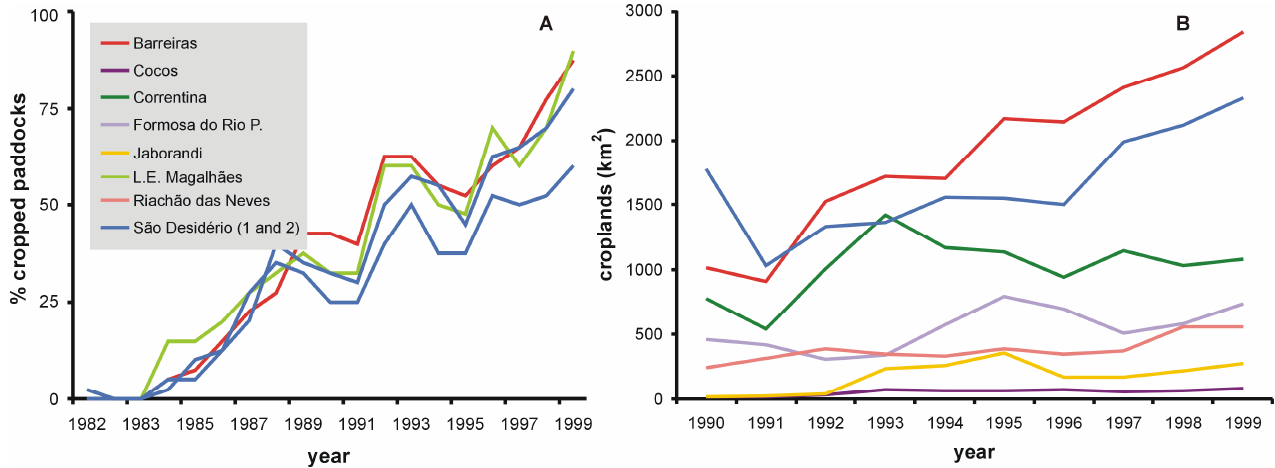
Figure 5. (a) Percentage of the area under agricultural activities measured through remote sensed information (1982-1999 period) for the three main counties (Barreiras, L.E. Magalhães and São Desidério), and (b) area in square kilometres under agriculture from statistics (1990-1999 period) for the entire region